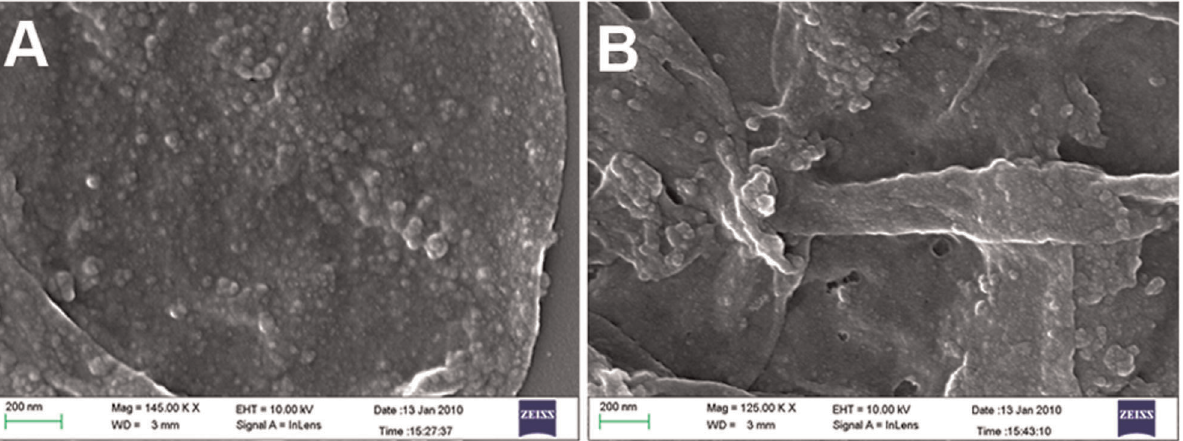
Figure 3. Surface characterization of nanoparticles-loaded PSS/PAH capsules. Scanning electron micrograph of (a) Au nanoparticles- loaded PSS/PAH capsules and (b) blank PSS/PAH capsules.